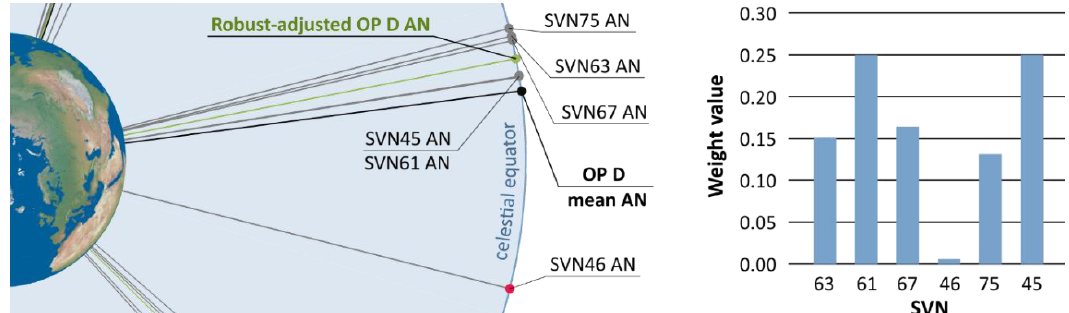
Figure 3. Comparison of the determination of the orbital plane (OP) D ascending node (AN) using the arithmetic mean and the robust estimation method with the weight values of the observations.